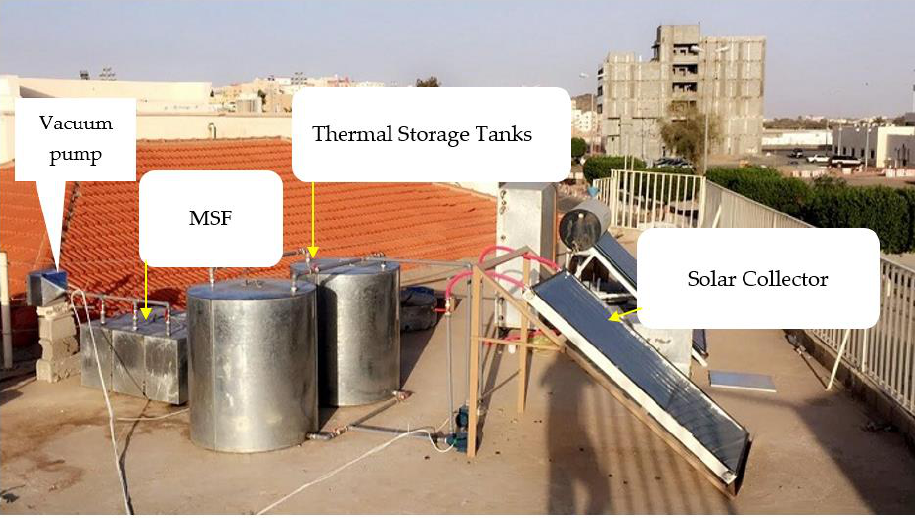
Figure 2. A photograph of the experimental system.